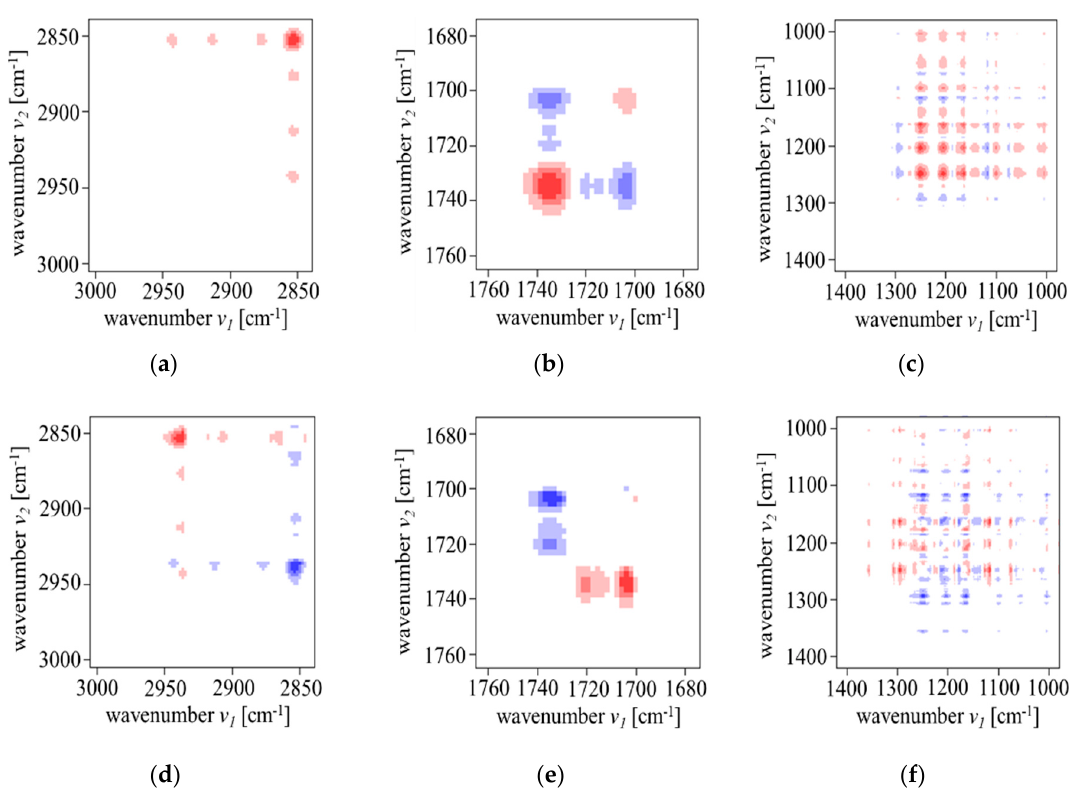
Figure Figure 6. Two-dimensional correlation analysis (2D-COS) correlation ( a – c ) synchronous and ( d – f )